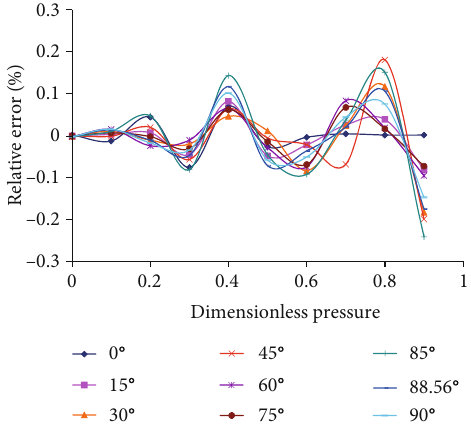
Figure 8: Relative error of normalized dimensionless yield fi tting of type 7 IPR